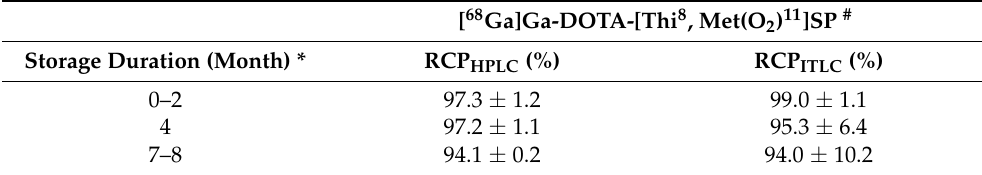
Table 4. Radiolabeling performance over time of [ 68 Ga]Ga-DOTA-[Thi 8 , Met(O 2 ) 11 ]SP